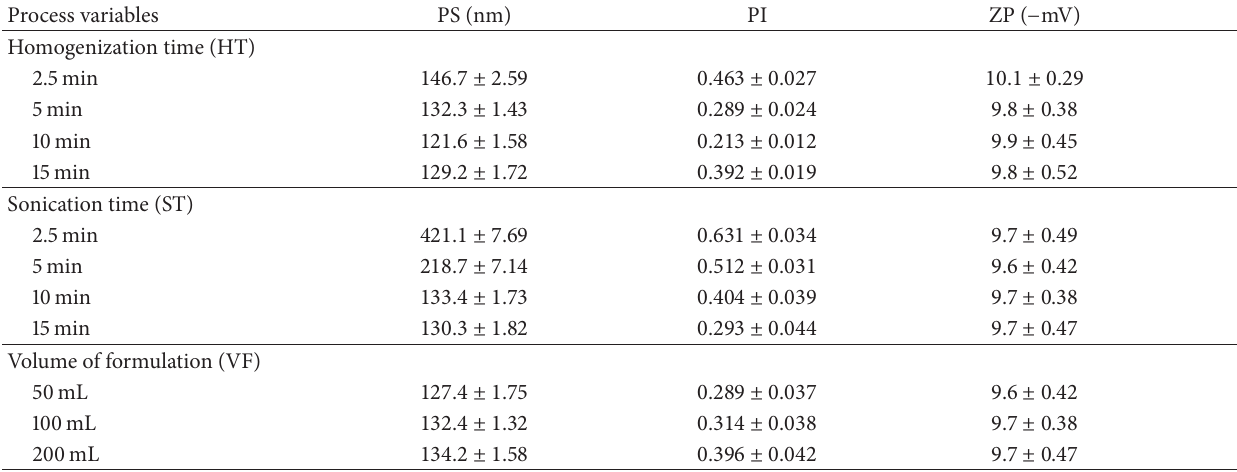
Table 1: Effect of different process parameters on particle size (PS), polydispersity index (PI), and zeta potential (ZP). Process variables